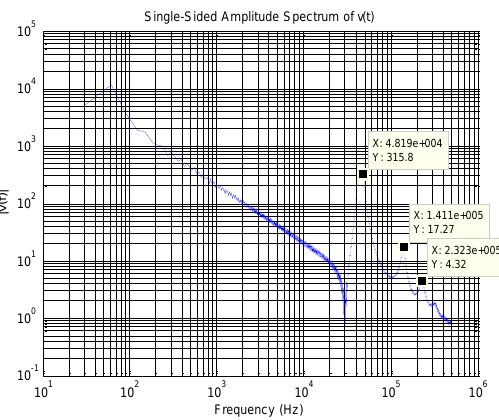
Fig. 5. The transformer secondary side terminal voltage.